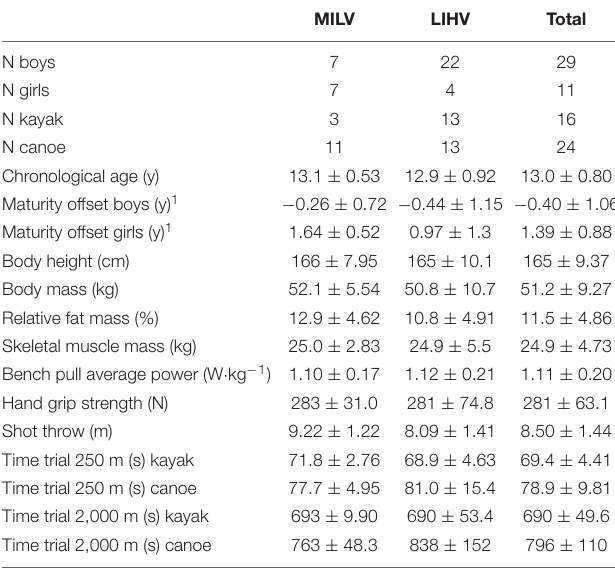
TABLE 1 | Participant characteristics at